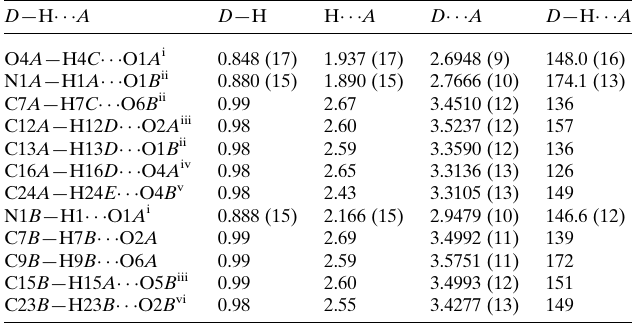
C22 A bond with a distance of 2.6715 (6) A˚ . Links alternating